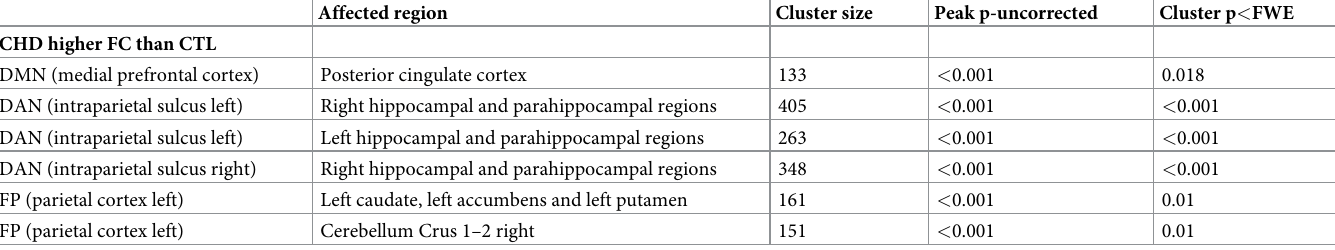
Table 4. Functional connectivity differences between CHD and control groups where CHD participants presented with higher functional connectivity than controls.